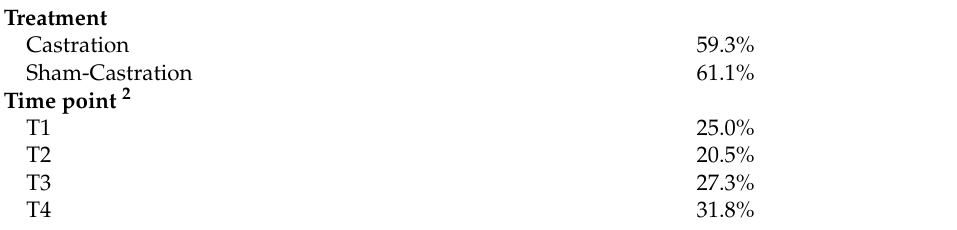
Figure 4. Distribution of ( A ) orbital tightening, ( B ) ear position, ( C ) temporal tension, ( D ) lip contraction, and ( E ) nose bulging/cheek tension scores at each time point (T1 = immediately before castration; T2 = immediately after castration; T3 = 4 h post-castration; and T4 = 22 h post-castration) for both treatments (C = Castration and S = Sham-castration). Table 3. Cross-validation discriminant analysis results utilizing landmarks capturing orbital tightening 1